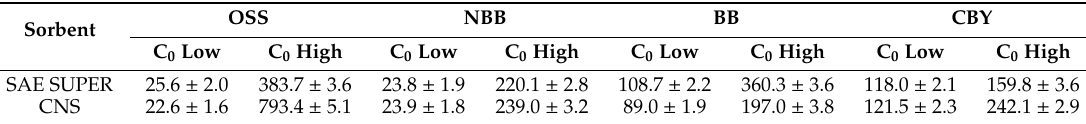
Table 6. Comparison of sorption capacities (q e , (mg / g)) determined at C 0 low and C 0 high for SAE SUPER and CNS (for C 0 values see Table